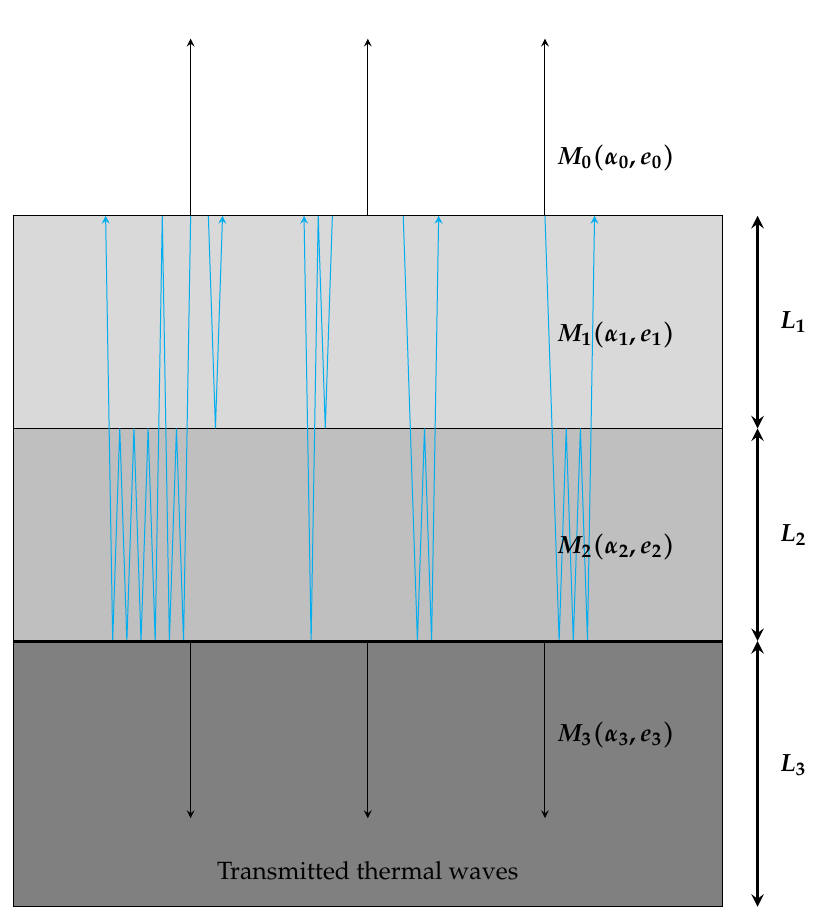
Figure 7. System of two layers of coatings M 1 – M 2 and one layer of substrate M 3